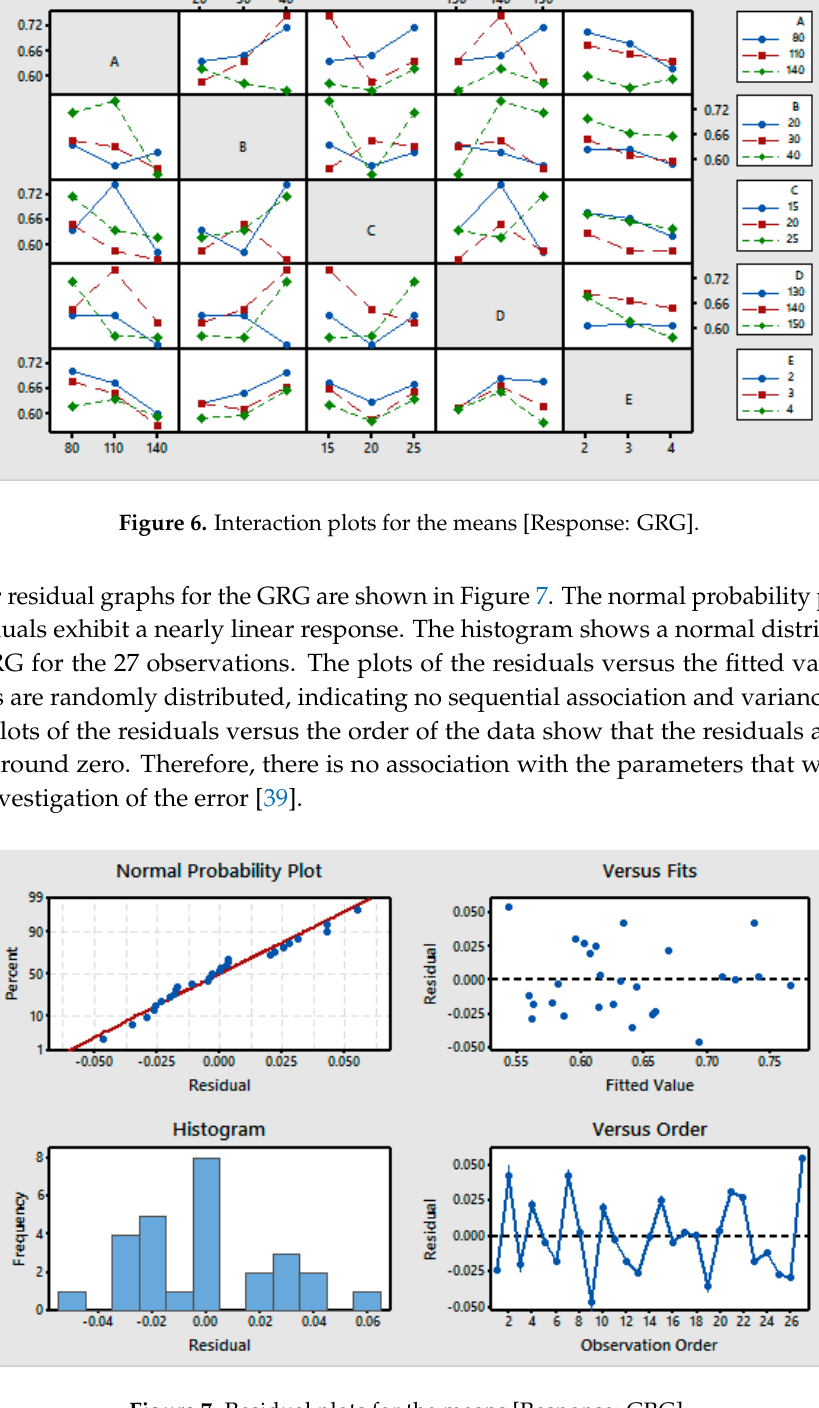
Figure 6. Interaction plots for the means [Response: GRG]. Table 13. ANOVA for the GRG.